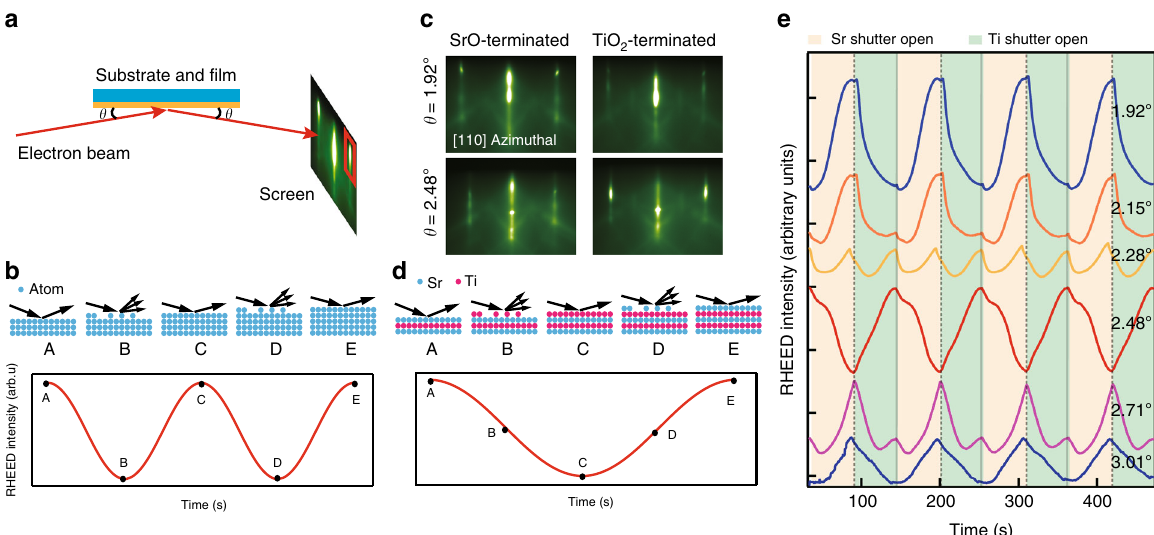
Fig. 1 Phase inversion and frequency doubling of RHEED oscillations during the growth of SrTiO 3 fi lms. a Schematic of a typical RHEED system. b In a simple model, the diffuse scattering from periodic surface roughing results in the variation of the RHEED intensity. Its period corresponds to the growth of a monolayer of material. c RHEED patterns of SrTiO 3 fi lms taken along the [110] azimuthal direction typically show maximum (minimum) diffraction intensity in the case of SrO- (TiO 2 -) terminated surfaces, but this surface termination dependence can be reversed by changing the incident angle of the electron beam. d RHEED intensity oscillations of (11) diffraction peaks during the atomic layer-by-layer growth of SrTiO 3 fi lms shows a period corresponding to two monolayers, which cannot be explained by the simple step edge density model. e The intensity of the (11) diffraction peak oscillates during the atomic layer-by-layer growth of SrTiO 3 fi lms and its period and phase strongly depend on the incident angle of the electron